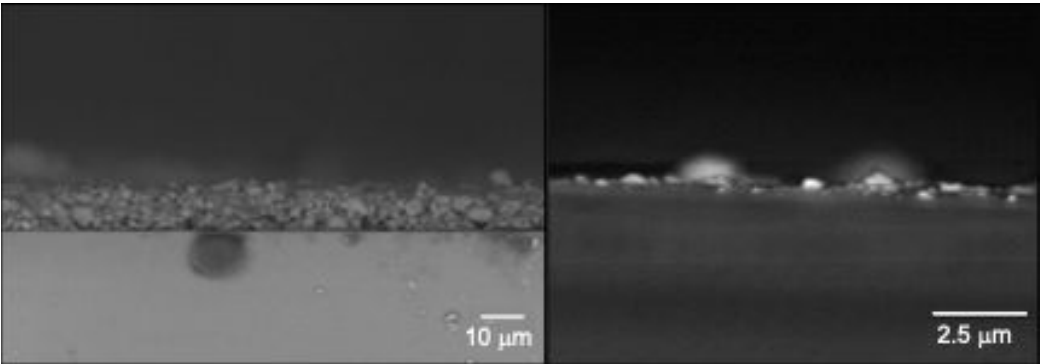
film with 1,000 X magnification (left); and backscattered electrons 2